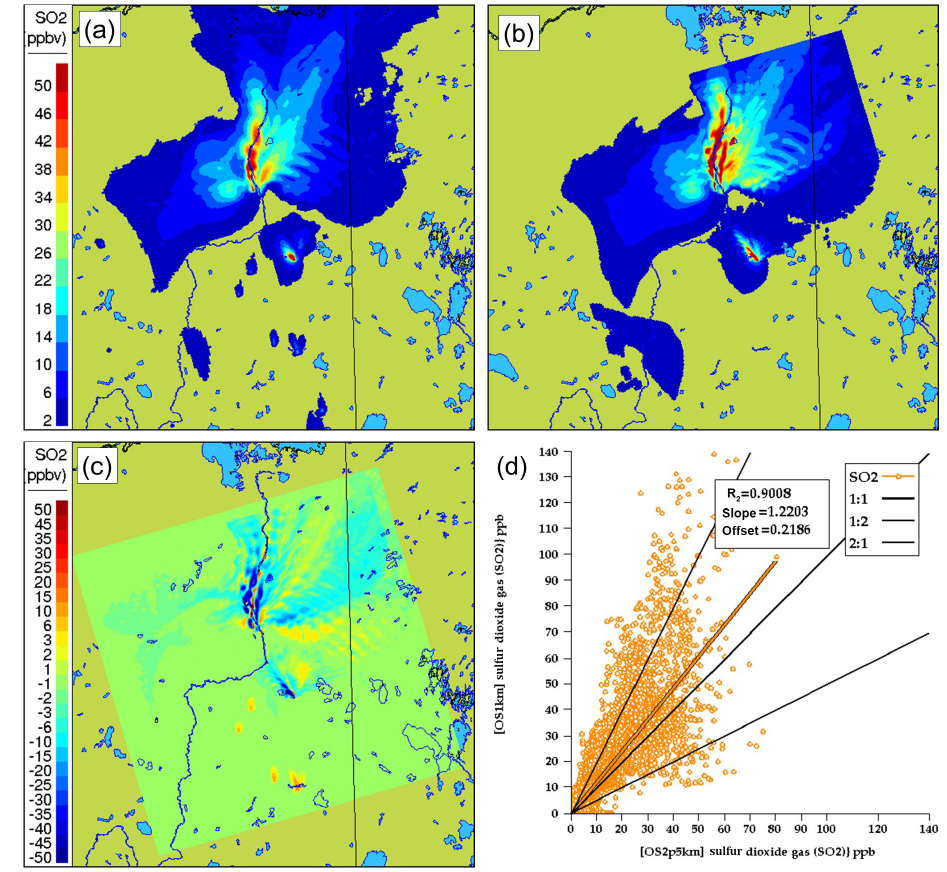
Figure 6. Comparison of total-simulation maximum surface SO 2 mixing ratios (ppbv) at (a) 2.5km and (b) 1km grid-cell size (ppbv). (c) Difference (2 . 5 − 1km). (d) Scatter plot of 2.5km ( x axis) versus 1km ( y axis) total simulation average grid-cell surface SO 2 mixing